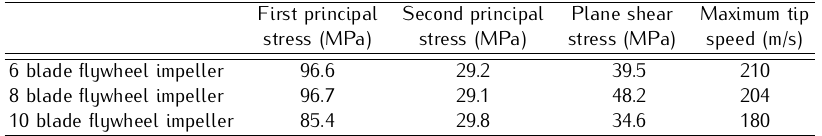
Table 2. Maximum tip speed for different impeller patterns.